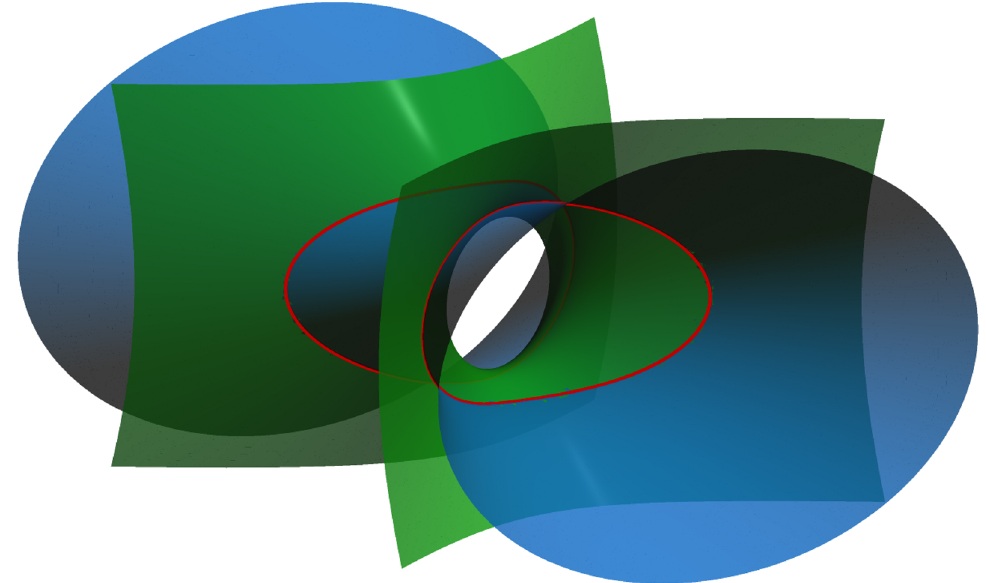
Figure 3 . Two intersecting quadrics. Their intersection is the genus-one curve C in the elliptic double